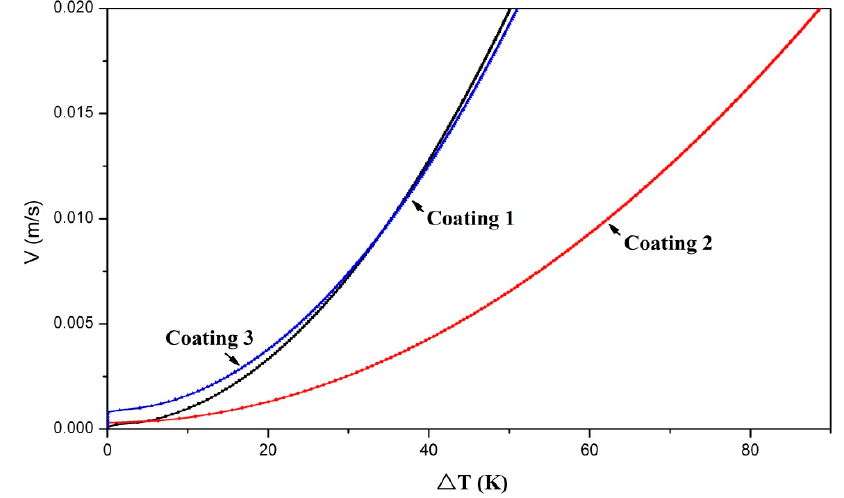
Figure 9. Solidification front velocity with the increase of dendrite tip undercooling ( Δ T ).